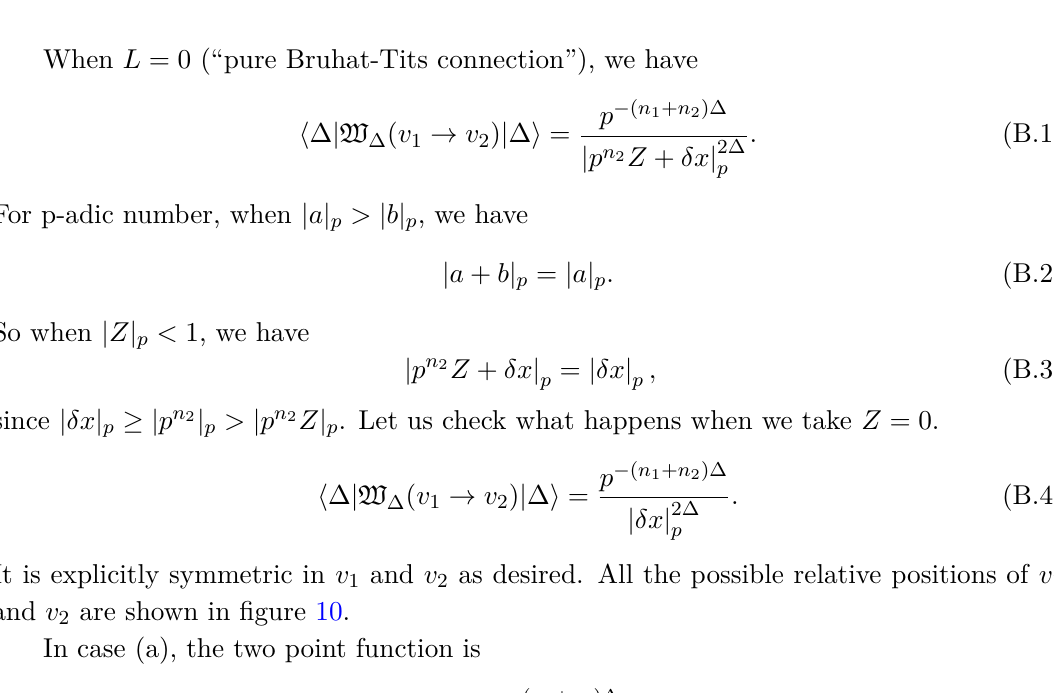
Figure 10. There are three types of relative positions. In (a), | δx | p = p − n 3 . In (b), | δx | p = p − n 1 . In (c), | δx | p = p − n 2